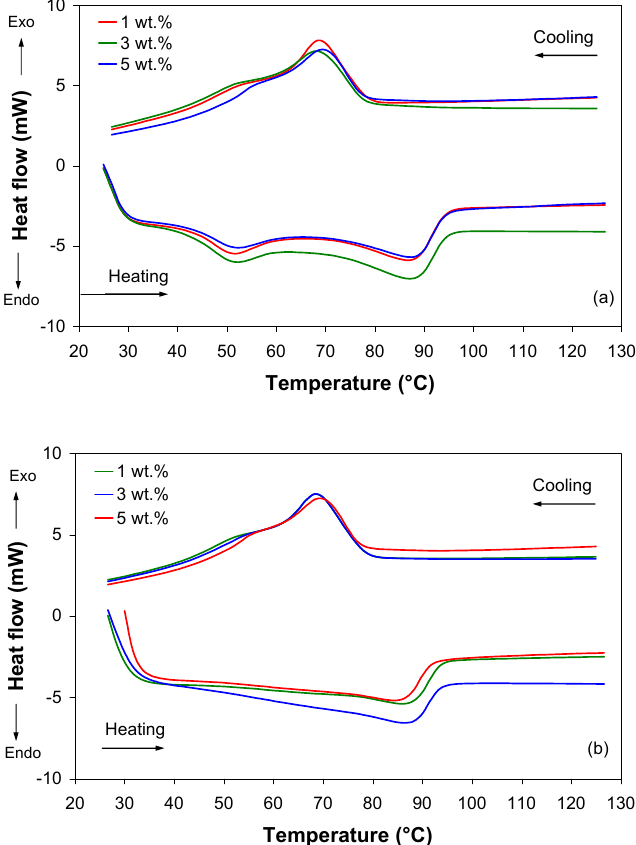
Figure 1. DSC curves at heating and cooling rate of 10 ◦ C / min: ( a ) first DSC scan and ( b ) second DSC scan.